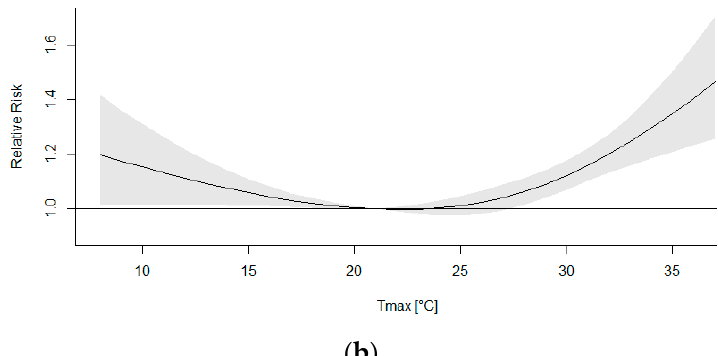
Figure 12. Relation between daily maximum temperature and relative mortality risk (cardiovascular